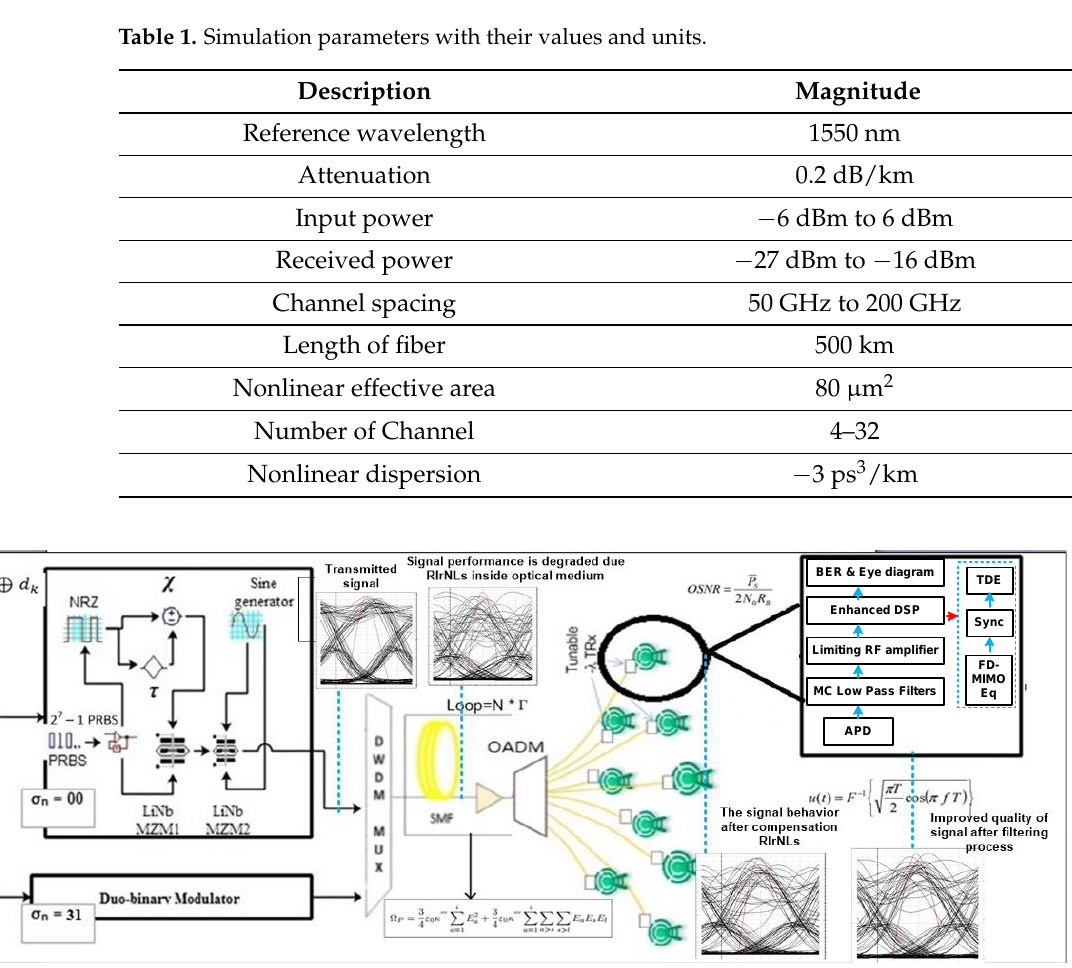
Figure 1. WDM based OTN model for mitigation of